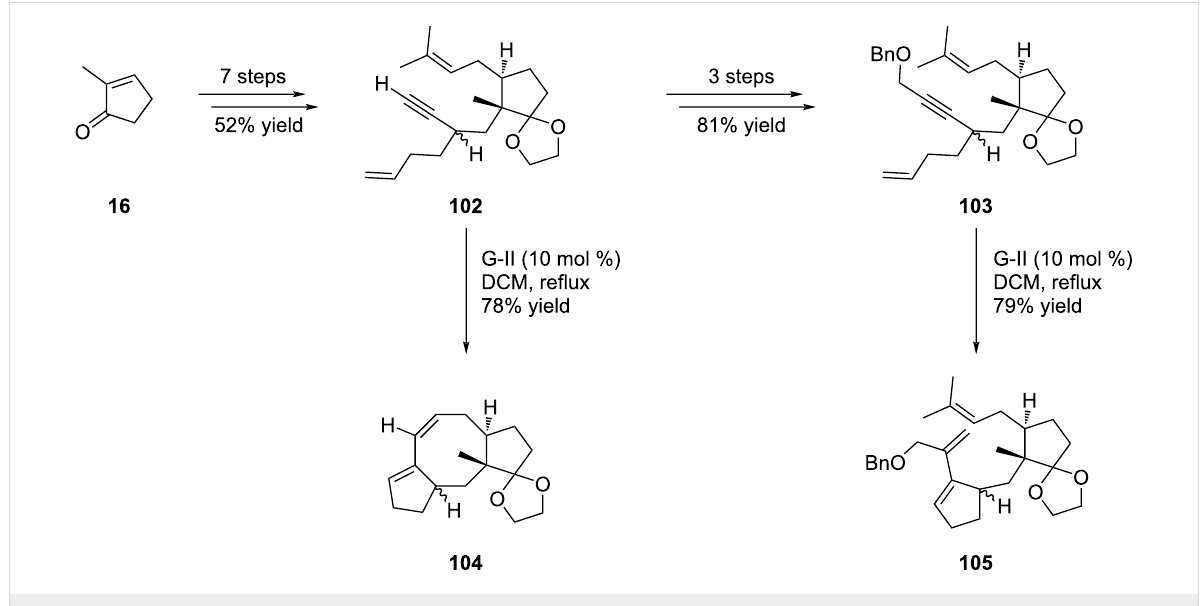
Scheme 18: First attempts of TRCM of dienyne